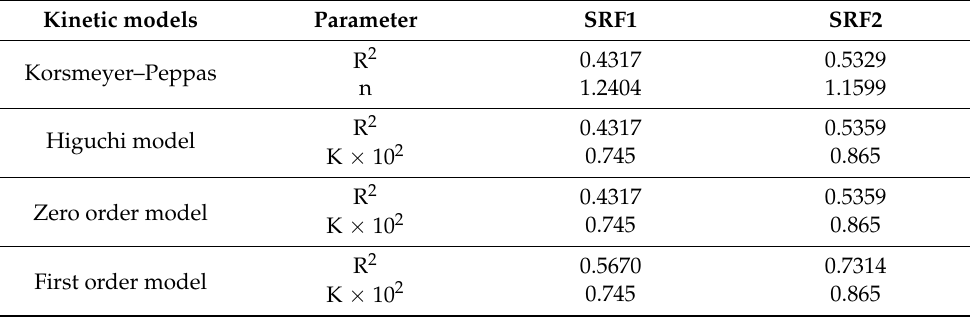
Table 3. Kinetic parameters from different model for fertilizer release in